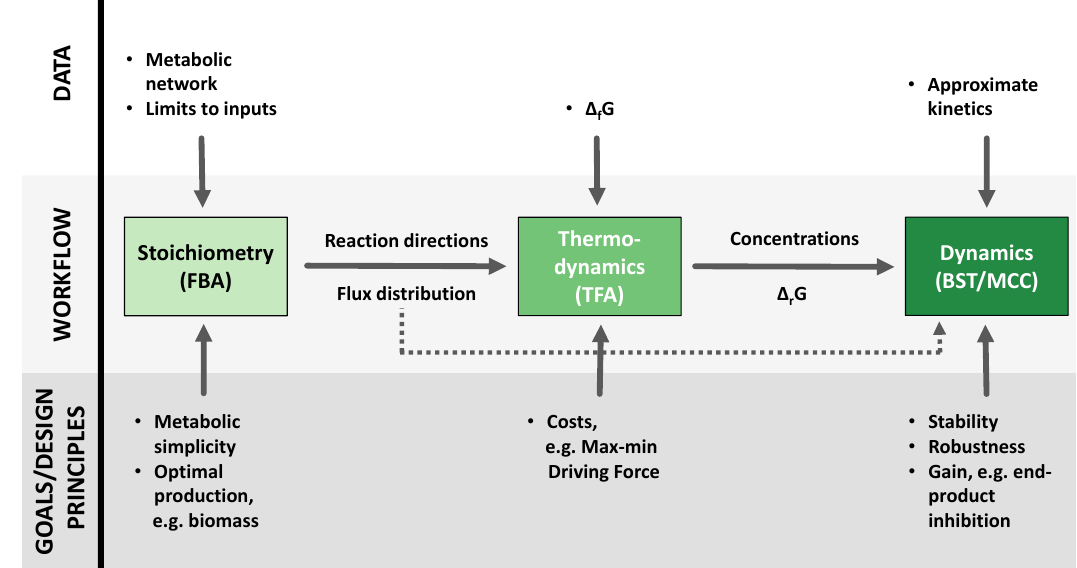
Figure 1. A sequential workflow from metabolic reconstructions to dynamic models.